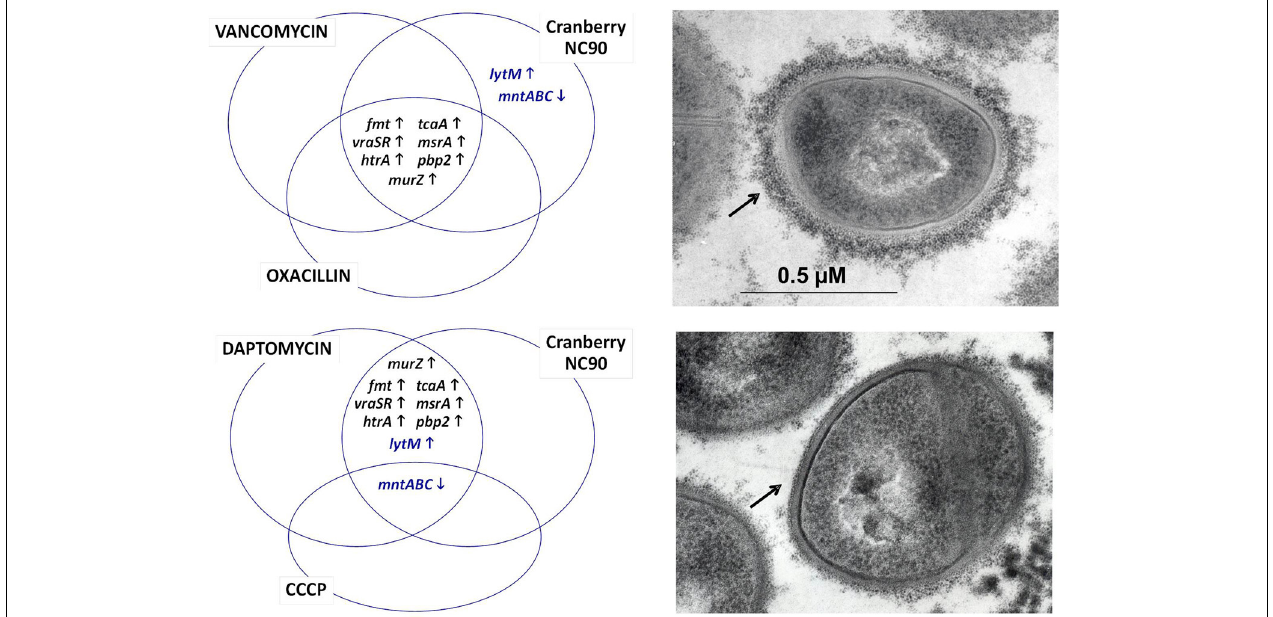
FIGURE 1 | Venn diagrams showing some of the S. aureus genes up- and down-regulated following exposure to cranberry (left). The transcriptional signature resembles to that of the cell wall stress stimulon provoked by peptidoglycan biosynthesis inhibitors such as vancomycin, oxacillin, and to some extent daptomycin. Compounds causing membrane depolarization like daptomycin and CCCP also share a common transcriptional signature with cranberry. Genes up- and down-regulated are